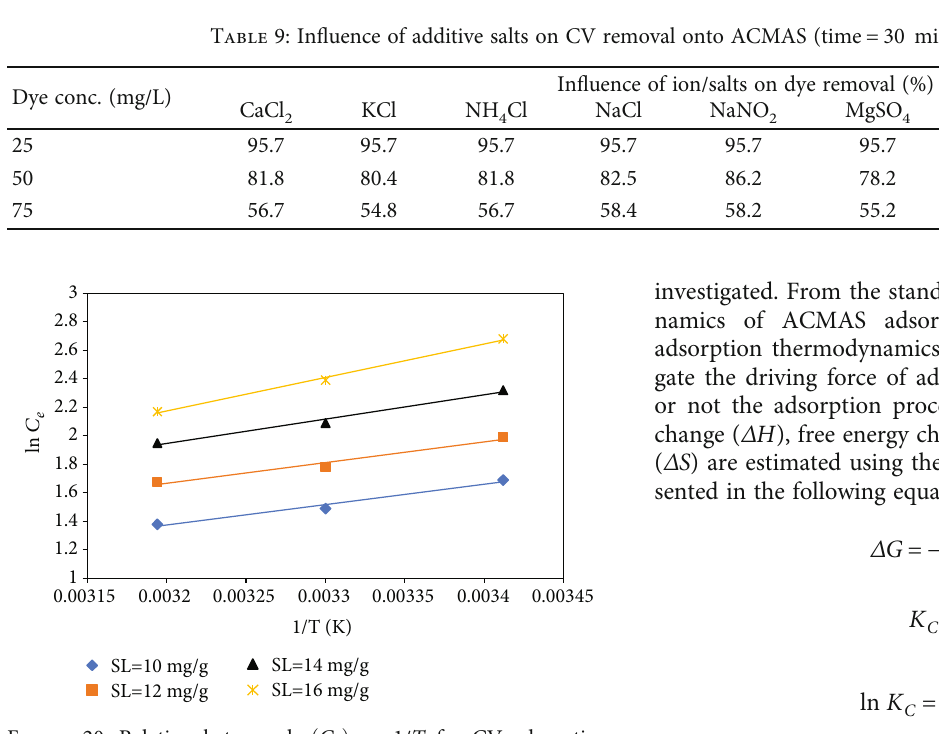
Figure 20: Relation between ln ð C onto ACMAS.